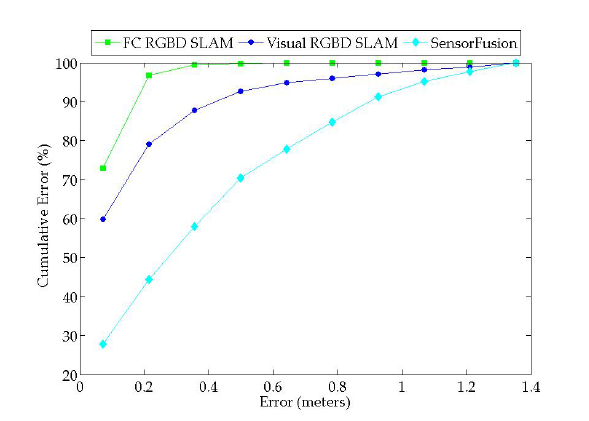
Figure 4. Average cumulative error histogram for all captured